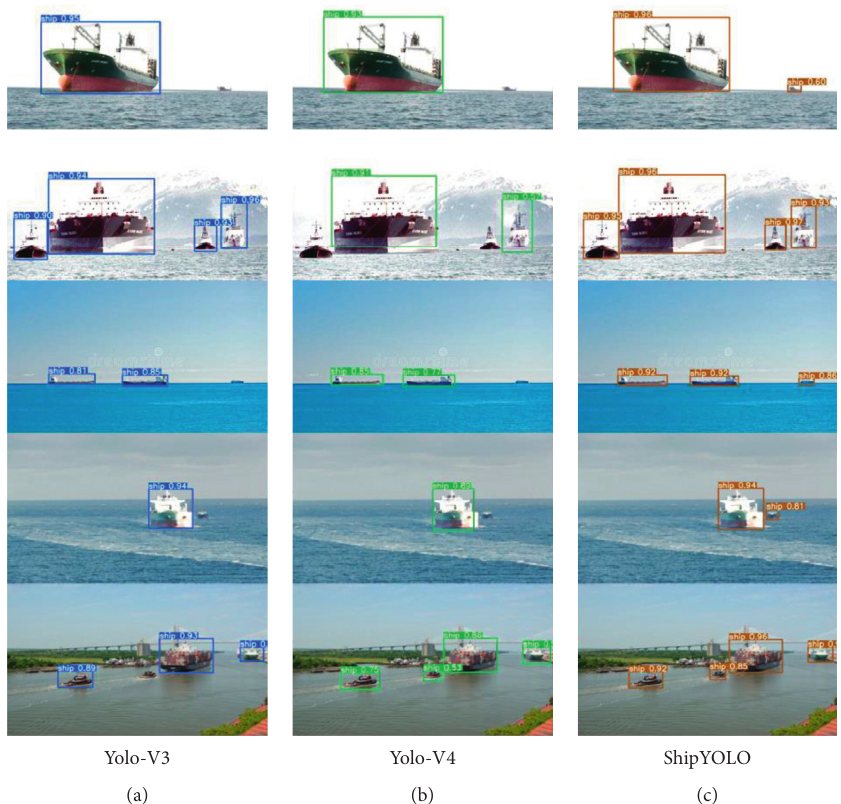
Figure 11: Validation result of the dataset by